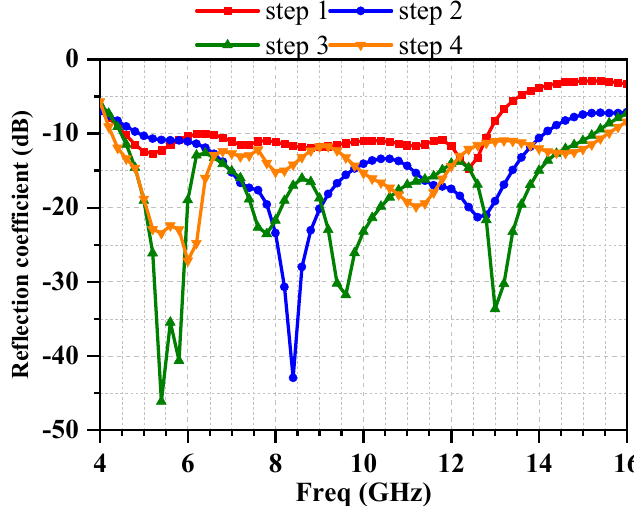
Figure 4. Comparison of reflection coefficients of 4 proposed UWB-MIMO antenna designs.